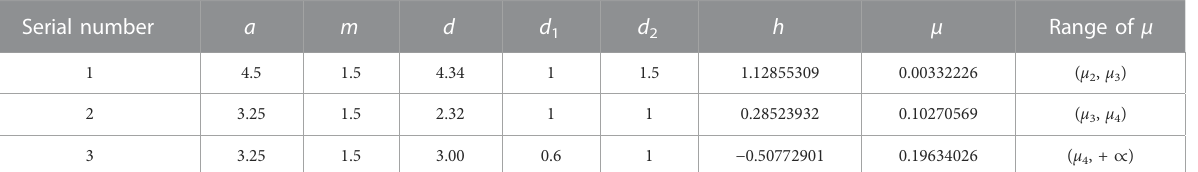
TABLE 3 Different values of